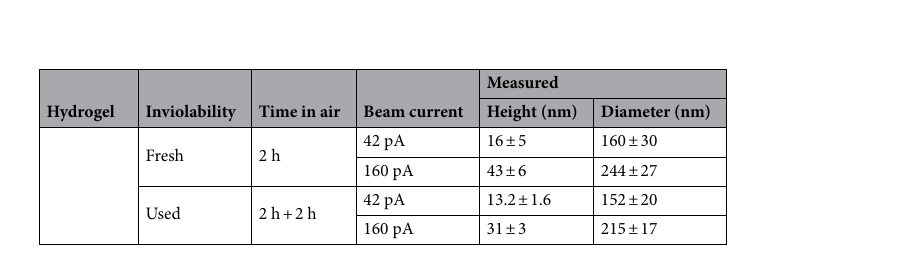
Table 3. Influence of hydrogel drying on the dimensions of the nanopillars (data reliability 95%).